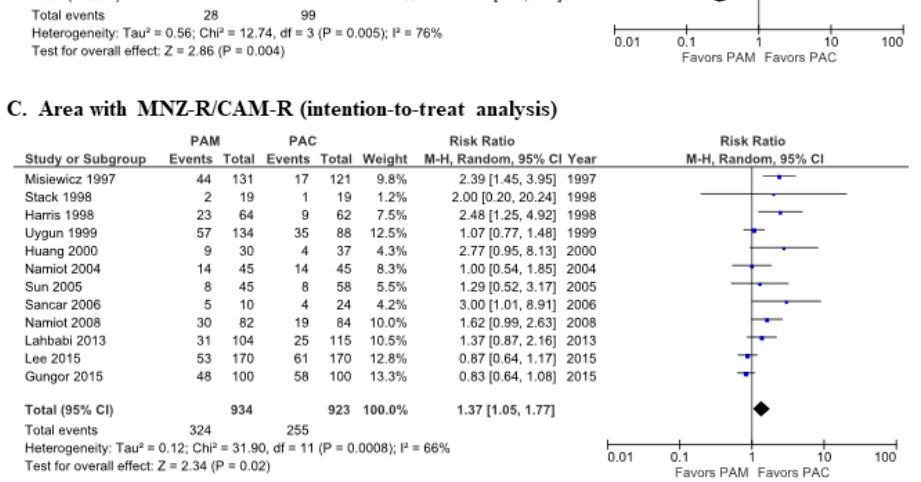
Figure 4. Forest plots of eradication rates between PAM therapy and PAC therapy in areas classified as having ( A ) low clarithromycin resistance (< 15%) and high metronidazole ( ≥ 15%) resistance, ( B ) high clarithromycin resistance and low metronidazole resistance, and ( C ) high clarithromycin resistance and high metronidazole resistance in intention-to-treat analysis. Abbreviations: CAM, clarithromycin; CI, confidence interval; MNZ, metronidazole; PAC, proton pup inhibitor (PPI)/amoxicillin/clarithromycin; PAM,